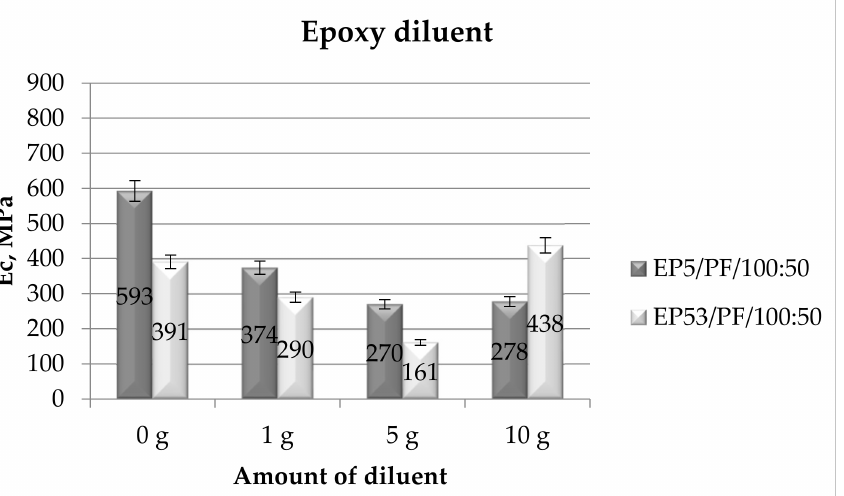
Figure 5. Compressive modulus calculated for Epidian 5 and Epidian 53 epoxy compounds as a function of the amount of epoxy diluent.